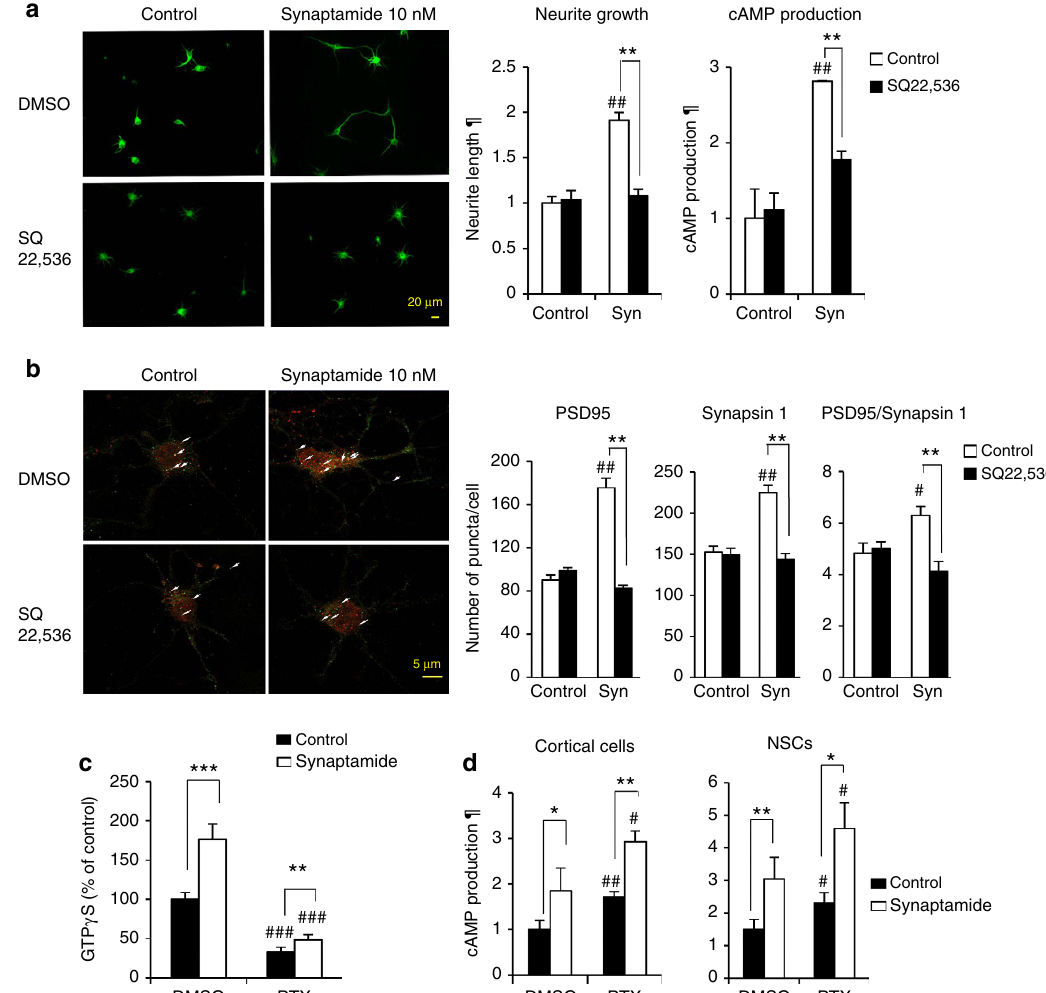
Figure 1 | cAMP-dependent induction of neurite outgrowth, synaptogenesis and neurogenesis by synaptamide. In cortical neurons, 10nM synaptamide (Syn) increased cAMP production, neurite outgrowth ( a ) and synaptogenesis ( b ) while pretreatment with SQ22,536 for 30min prevented these effects. Neurite outgrowth and synaptogenesis were evaluated after treating neurons from day 1 in vitro (DIV1) for 2 or 6 days, respectively, while cAMP production and CREB phosphorylation were determined after stimulating DIV3 neurons with synaptamide for 10min. Neurons and nuclei were visualized using MAP2 antibody (green) and DAPI (blue). Co-localization analysis of presynaptic marker synapsin1 (red) and postsynaptic marker PSD95 (green) revealed increased synapses (overlapping synapsin1/PSD95 puncta indicated by arrows) by synaptamide treated cortical neurons but not in the presence of SQ22,536 ( b ). For quantification of synaptic protein puncta, 20 cells were scored per well for 3 wells per each group. Synaptamide at 10nM induced G-protein activation ( c ). The [ g - 35 S] GTP binding was measured after treating NSC membranes with 10nM synaptamide for 15min with or without overnight pretreatment with pertussis toxin (PTX, 0.1 m gml (cid:2) 1 ). While expected increases in cAMP production were observed after PTX pretreatment of cortical cells or NSCs, synaptamide remained capable of increasing cAMP ( d ). Values are expressed as means ± s.e.m. of biological triplicates ( n ¼ 3), representing three independent experiments. Statistical analysis was performed using unpaired Student t -test. # P o 0.05, ## P o 0.01, ### P o 0.001, * P o 0.05, ** P o 0.01, *** P o 0.001 in comparison with the corresponding control. z , relative to control. Scale bars, 20 m m ( a ) and 5 m m ( b